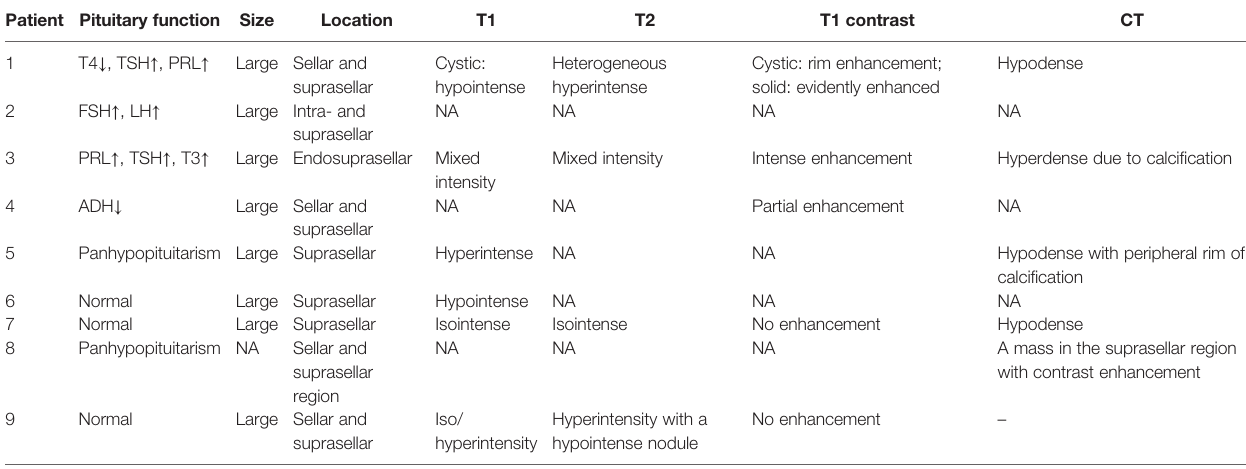
TABLE 3 | Pituitary function and pituitary magnetic resonance imaging data from published reports. Patient Pituitary function Size